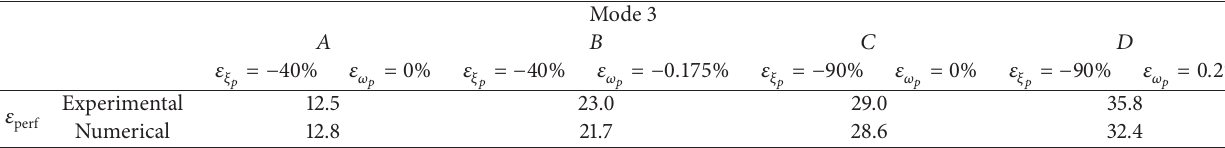
Table 8: Test cases for Mode 3.